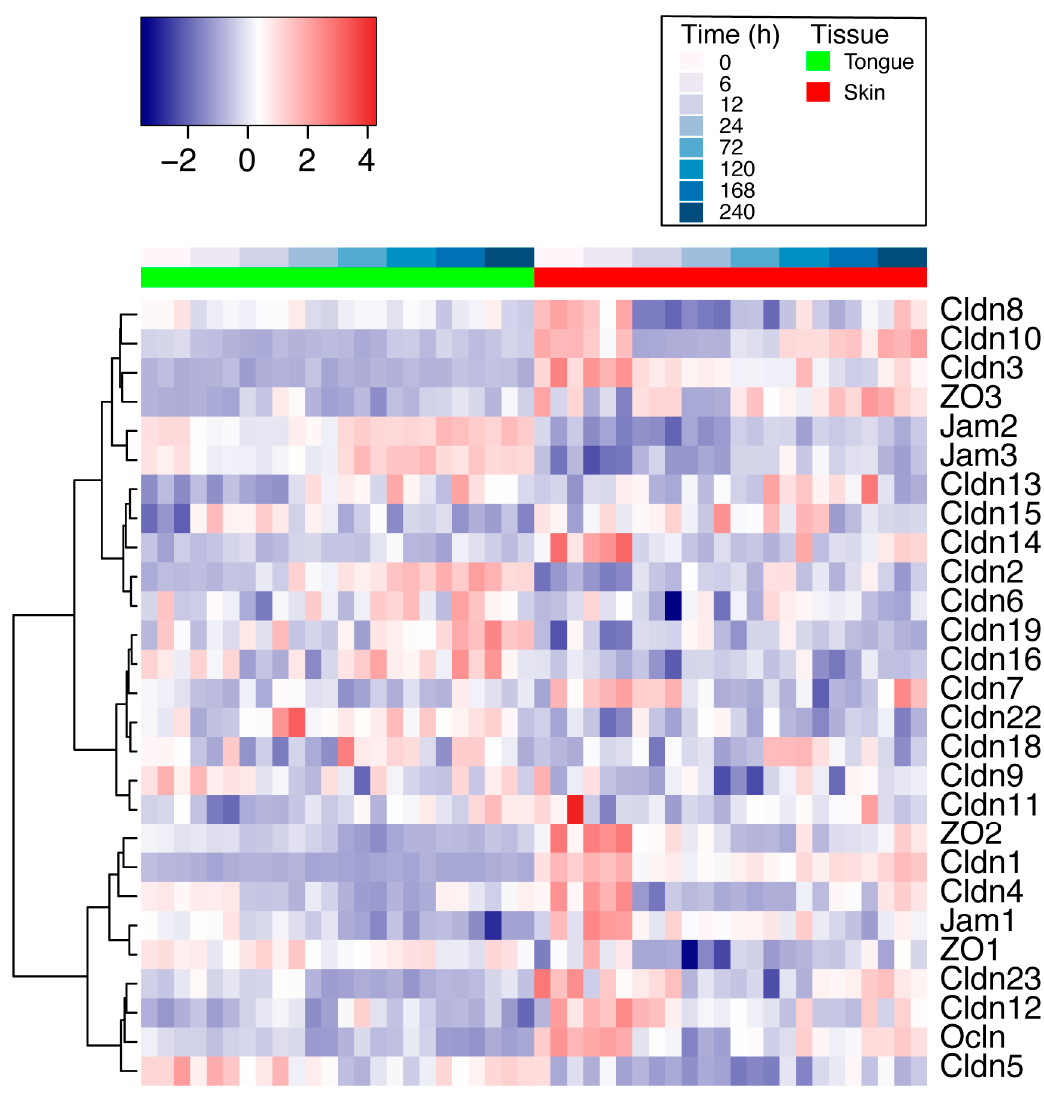
Figure 2. Differential expression analysis of tight junction molecules in mouse skin and oral wounds in vivo. A heatmap displaying the gene expression profiles of the 27 TJ genes analyzed in response to wounding over 10 days in both skin and tongue wounds. Genes were hierarchically clustered using the Euclidean distance measure and complete clustering, with gene expression scaled across rows. Each row is a gene and each column is a sample at a specific time point. Time 0 represents baseline expression in normal tissue, and subsequent time points represent hours after wounding. Samples are displayed in response to injury over time, going left to right for each tissue using a white–blue color scale bar, with tissues denoted by green or red color bars. n = 3 mice per group per time point for both skin and oral wounds.